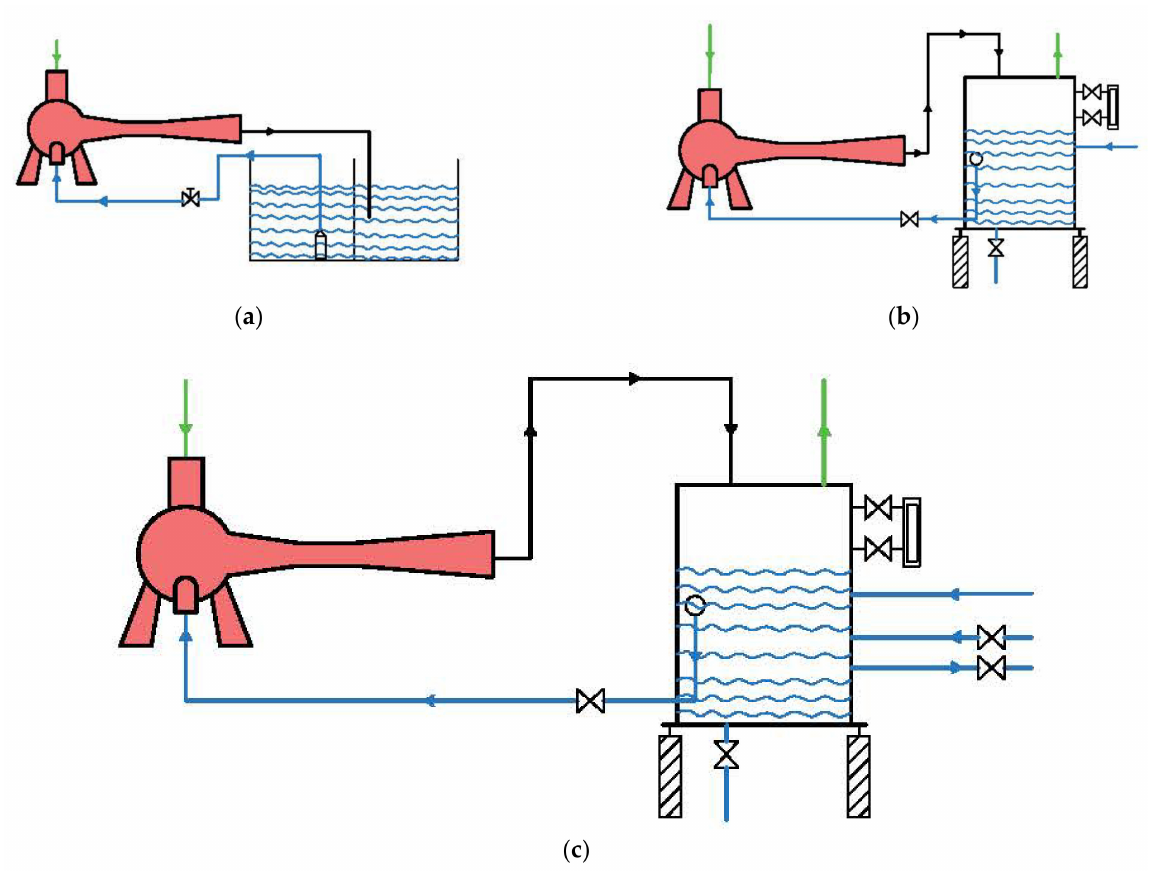
Figure 5. Application of the CJVP in thermal power plant. ( a ) Open primary circulation, ( b ) secondary circulation, ( c ) closed